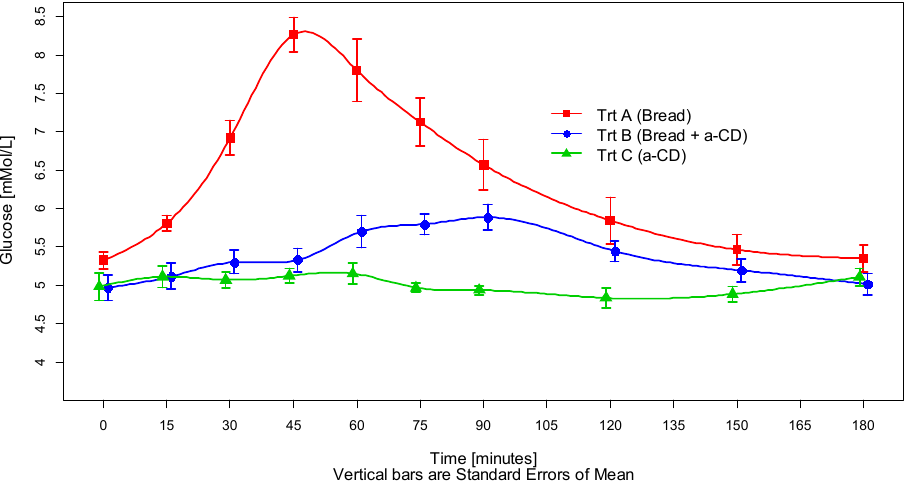
MeanTime [minutes] Vertical bars are Standard Errors of Figure 1. Glycemic response curves elicited by 100 g white bread consumed with 250 mL plain drinking water (treatment A), or 100 g white bread consumed with 250 mL water containing 10 g dissolved alpha-cyclodextrin (treatment B) or 250 mL water with 25 g dissolved alpha-cyclodextrin (alpha-CD) only (treatment C). Values are the means of the 12 subjects with their SEMs represented by vertical